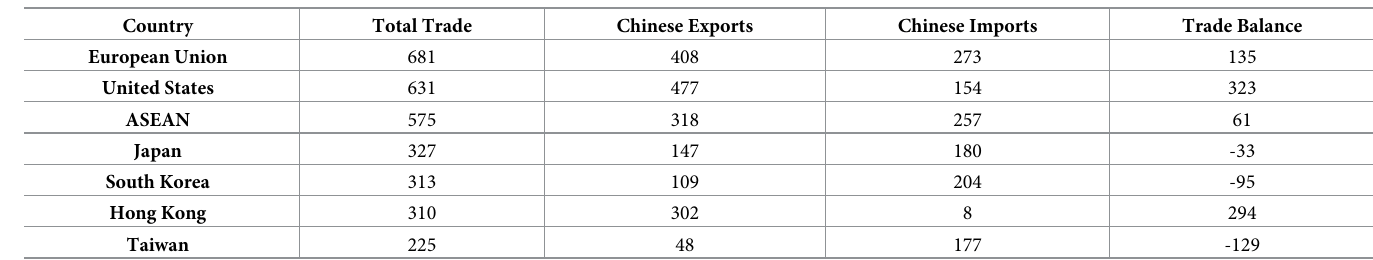
Table 3. China’s major merchandize trading partners in 2018 ($ billions).